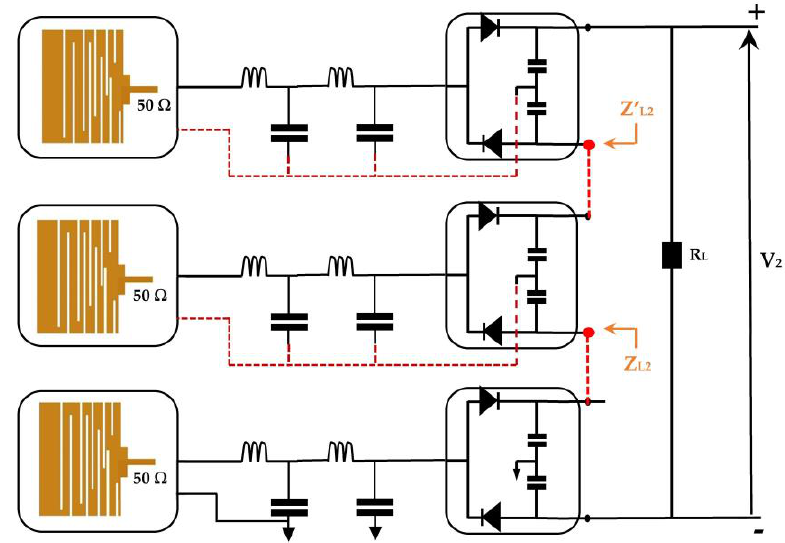
Figure 18. Second architecture with three rectennas matched to GSM-1800, UMTS, and LTE-2.6. Z L2 , Z’ L2 are the impedances at the selected points.